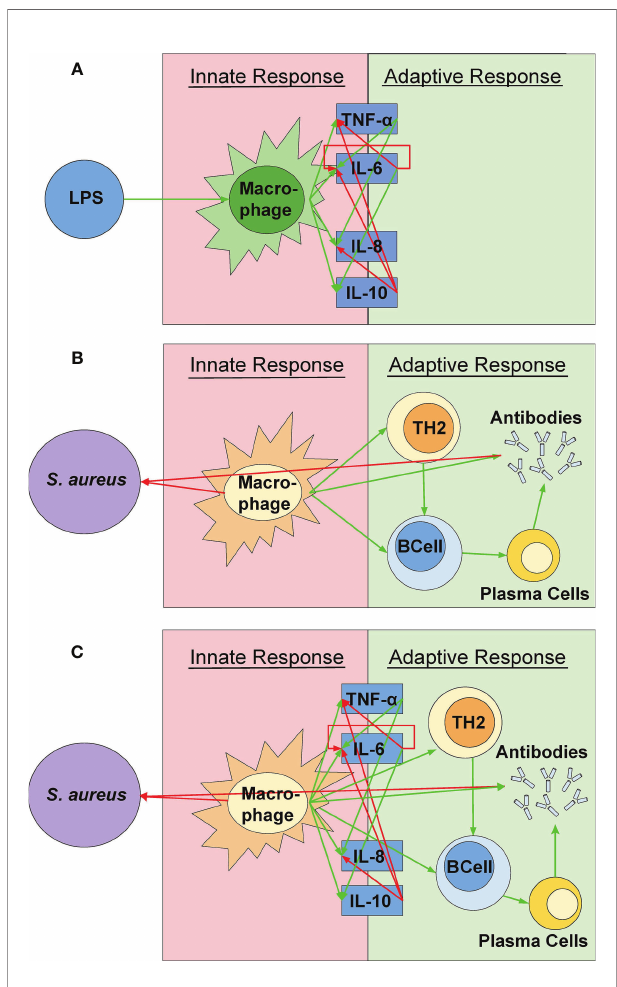
FIGURE 1 | A visual representation of the model components. (A) The simulation created by Quintela et al. representing the relationships between S. aureus and the different immune response cells were incorporated (Quintela et al., 2014). (B) A visual representation of the cytokine mathematical model as outlined by Brady et al. (2016). These relationships were used in the simulation via the relationships between the cytokines and the active macrophages rather than the pathogen itself (See Figure 2C ). (C) The coupled model represented in this study. The green and red arrows indicate a positive (up-regulation) and negative (down-regulation) response, respectively. The various shapes indicate the parts of the simulation from Quintela et al. while the dark blue boxes indicate the parts of the simulation from the mathematical equations from Brady et al. The concentrations of the cytokines are solely dependent on the macrophage concentration and are not directly affected by the pathogen